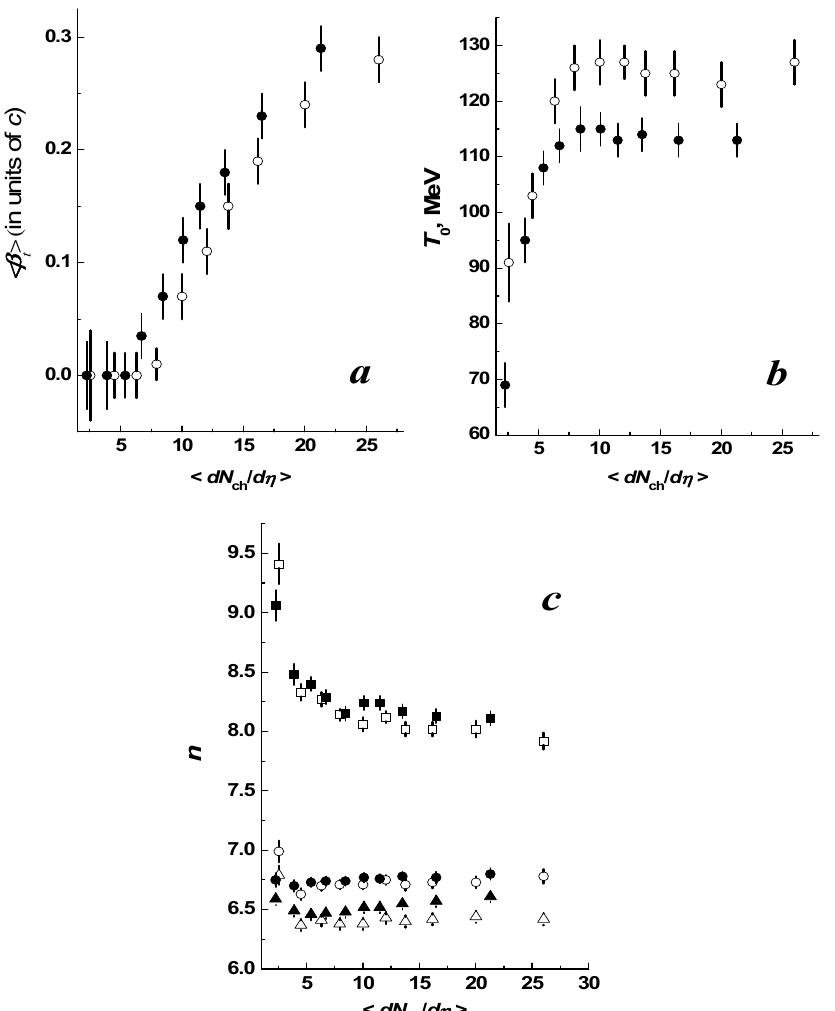
Figure 4. The < dN ch / d η > dependencies of the obtained (cid:104) β t (cid:105) ( a ) and T 0 ( b ) parameters ( • ) of the Hage- dorn function with included transverse flow, presented in Table 3, in proton-proton collisions at ( s ) 1/2 = 7 TeV. ( c )—The same for the obtained n values of the Hagedorn function with included transverse flow, presented in Table 3, for the charged pions ( • ) and kaons ( (cid:78) ), protons and antiprotons ( (cid:4) ). The corresponding results extracted from [21] for the respective particles in proton-proton collisions at ( s ) 1/2 = 13 TeV are shown by the corresponding open (hollow) symbols for comparison.